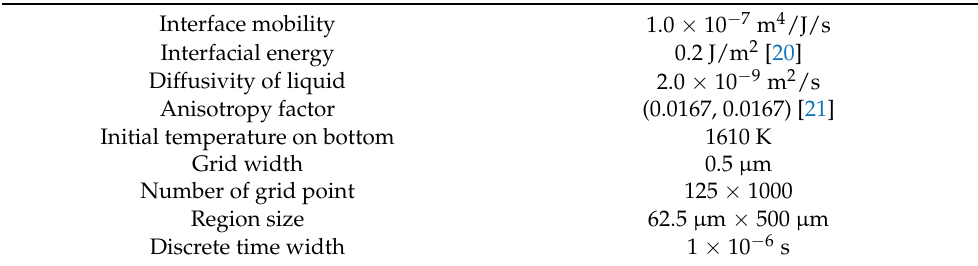
Table 4. Conditions of MPFM calculation under the conditions of the tenth layer position (p10).